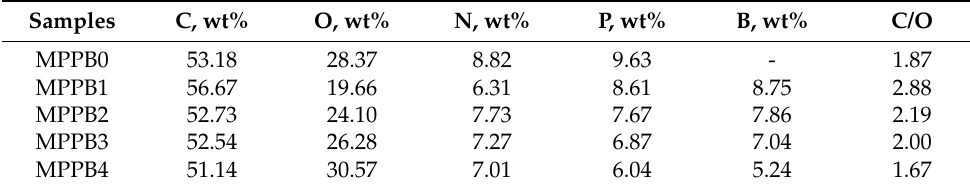
Table 5. EDS results of the char residues obtained from the cabinet method test.